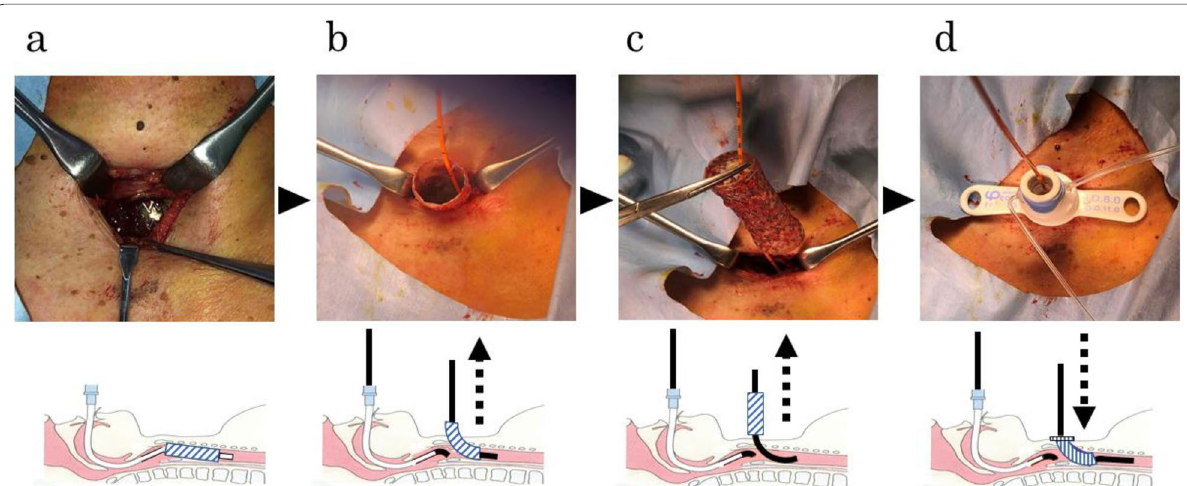
Fig. 1 Schema of the double gum elastic bougie technique. a The tracheal stent was exposed when the tracheal window was opened at the inferior border of the cricoid cartilage. b A gum elastic bougie was passed into the orally intubated tube, and the intubation tube was pulled to enable extraction of the tracheal stent from the tracheostomy. The cranial end of the tracheal stent was pulled out through the tracheal opening window. Another gum elastic bougie was passed through the tracheal stent lumen and advanced to the tracheal bifurcation. c The tracheal stent was removed while maintaining a secure airway through the orally intubated tube and the tracheal opening using two gum elastic bougies. d After removal of the tracheal stent, a tracheostomy tube was inserted through the gum elastic bougie